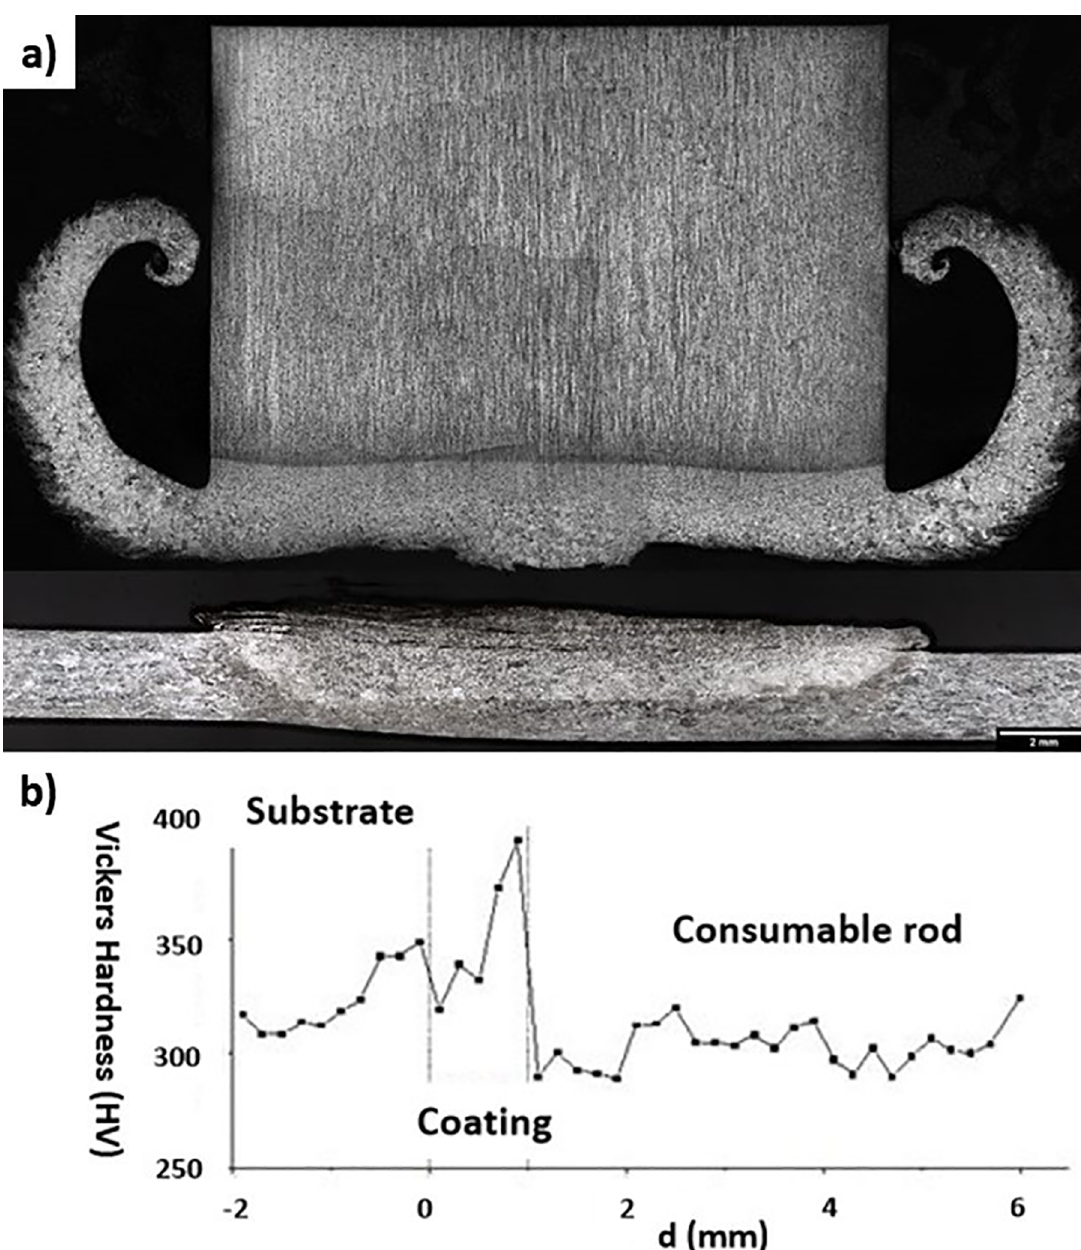
Figure 6. (a) Macrographs of the cross sections of rod and deposited coating on substrate and (b) microhardness evolution along the